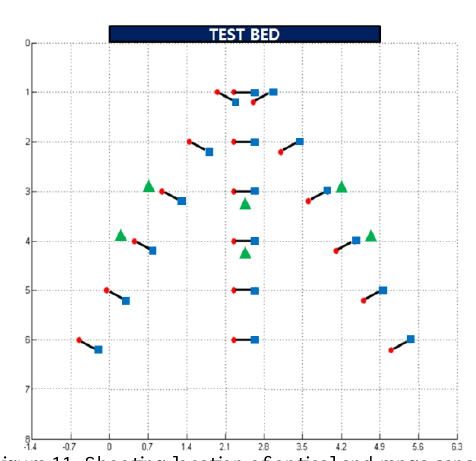
Figure 11. Shooting location of optical and range sensors (circles : optical sensor / squares: range sensor)